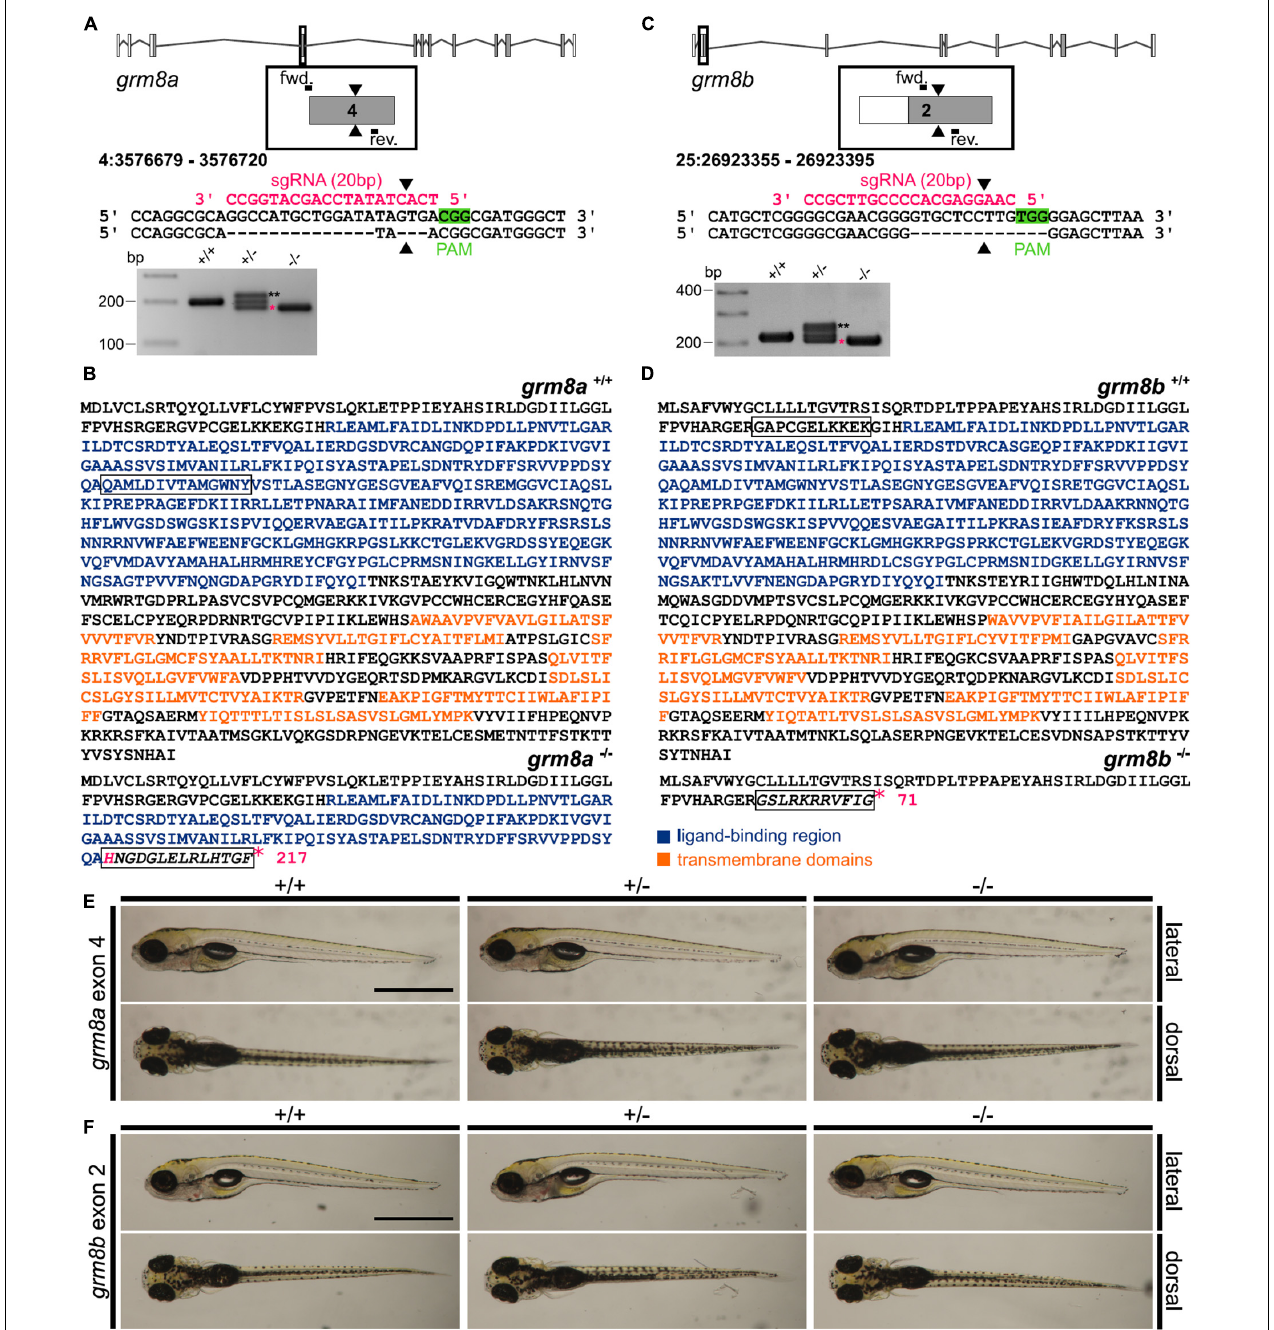
FIGURE 5 | Generation of grm8a and grm8b knock-out lines using CRISPR/Cas9. (A) Grm8a exon-intron structure (top) with coding (gray) and non-coding exons (white). The sgRNA (pink) targeting grm8a exon 4 and the primer binding sites for genotyping PCR are displayed. The CRISPR/Cas9-induced strand break (black arrowheads) caused a 17 bp deletion represented by a smaller PCR product (pink asterisk) in grm8a ± and grm8a − / − animals (bottom). The third band of ∼ 220 bp corresponds to a heterodimer of wildtype and mutated PCR product (black asterisks). (B) The predicted amino acid sequence of the wildtype (top) and mutated allele (bottom) show that the frameshifted sequence (black box) is interrupted by a premature stop codon (pink asterisk) in the ligand binding domain. (C) Grm8b exon-intron structure (top) with coding (gray) and non-coding exons (white). The sgRNA (pink) targeting grm8b exon 2 and the primer binding sites for genotyping are indicated. The CRISPR/Cas9-induced strand break (black arrowheads) caused a 13 bp deletion represented by a smaller PCR product (pink asterisk) in grm8b ± and grm8b − / − animals (bottom). The third band of ∼ 250 bp corresponds to a heterodimer of wildtype and mutated PCR product (black asterisks). (D) The predicted amino acid sequence of the wildtype (top) and mutated allele (bottom) shows that the frameshifted sequence (black box) is interrupted by a premature stop codon (pink asterisk) in the N-terminal domain. (E) Dorsal (top) and ventral (bottom) views of 5 dpf old grm8a + / + , grm8a ± and grm8a − / − zebrafish. Anterior is to the left. (F) Dorsal (top) and ventral (bottom) views of 5 dpf old grm8b + / + , grm8b ± and grm8b − / − zebrafish. Scale bar, 1 mm.